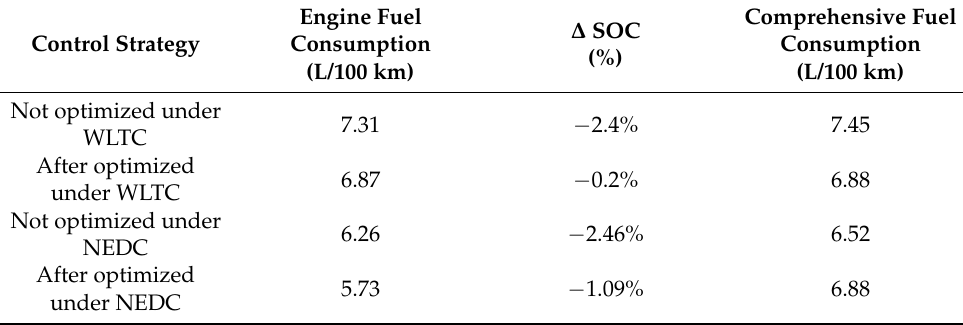
Table 8. The results of energy consumption in different control strategies.